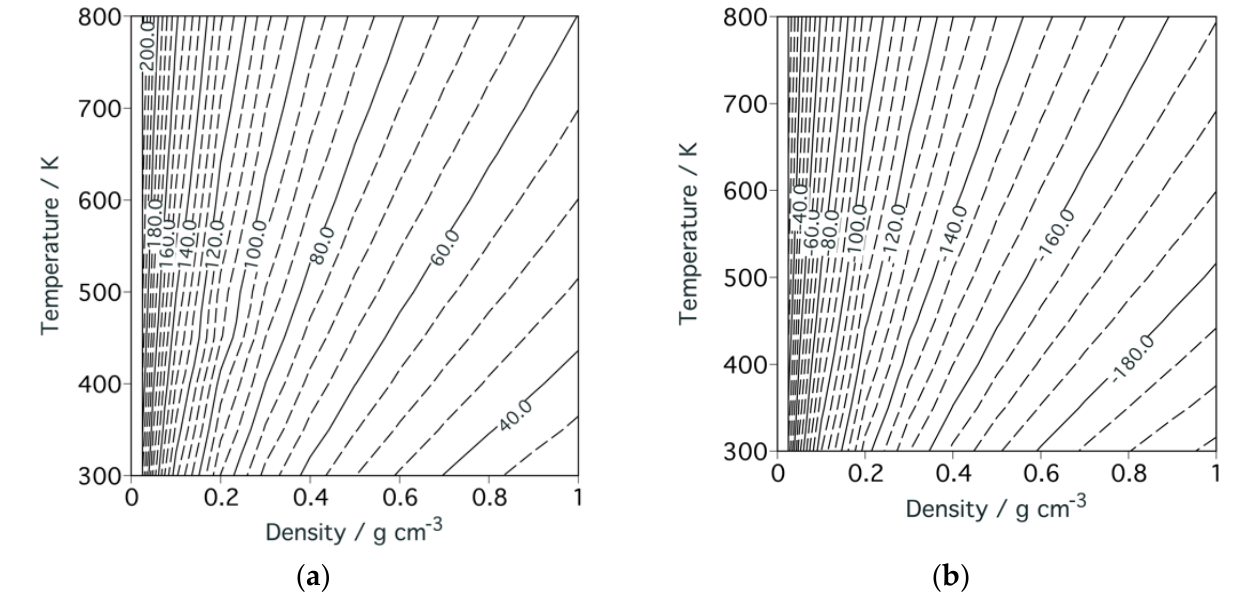
Figure 14. Density and temperature dependence of the Gibbs free-energy change for the autoionization process of water: ( a ) ∆ G aq and ( b ) ∆∆ µ . The units of the numbers on isochore lines are kcal mol − 1 . These figures are reprinted with permission from JPCB , 2006 , 110 , 8451. Copyright 2006 American Chemical Society.